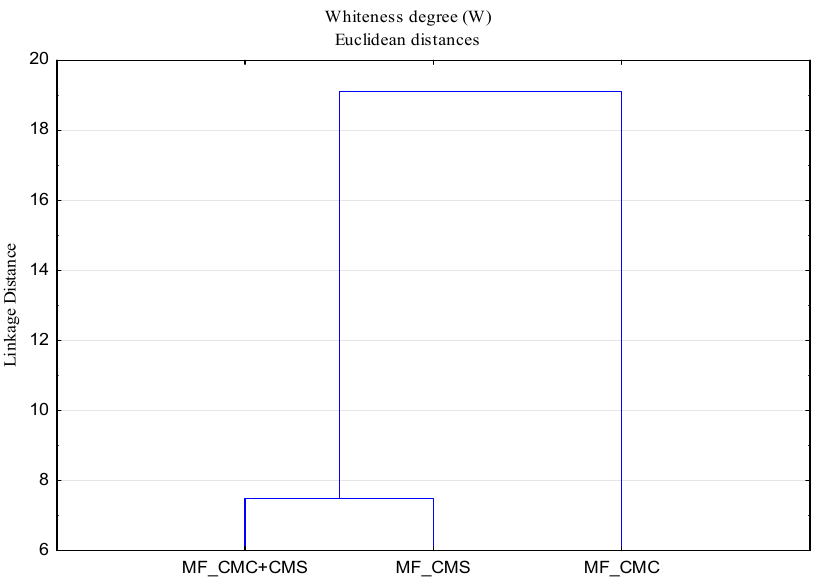
1 Table 4. Correlation matrix of CMS. Variable